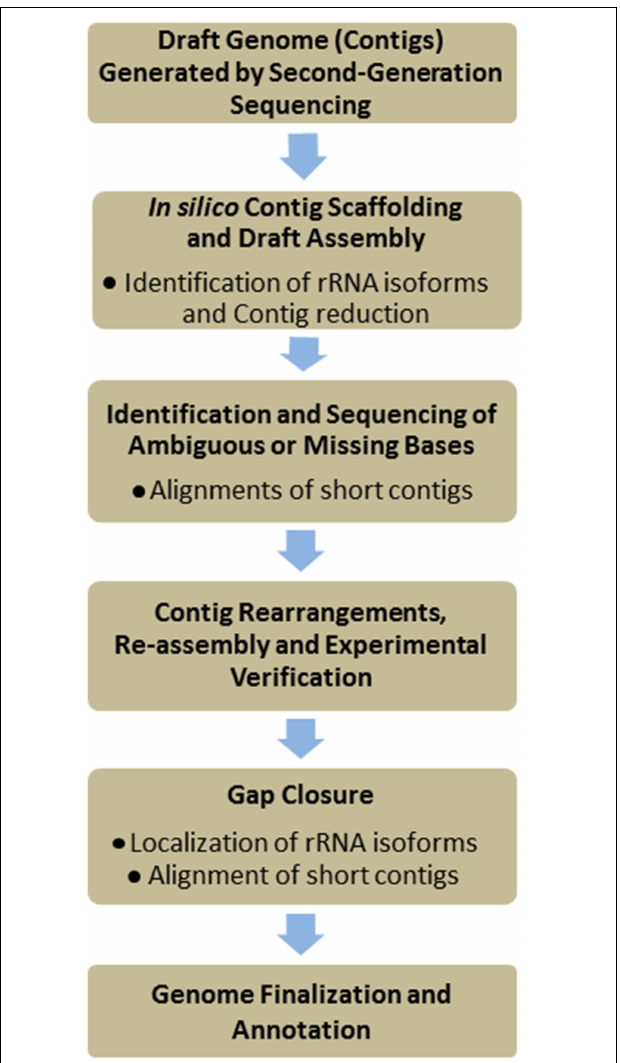
FIGURE 2 | Flow chart for de novo bacterial genome finishing. The assembly process is initially simplified by removal of contigs comprised entirely of rRNA genes. The draft genome is then scaffolded against other closely related strains and species to identify potential gaps, rearrangements, and missing sequences. Ambiguities in structure and nucleotide identity are targeted for Sanger re-sequencing. Furthermore, large scale rearrangements are carefully investigated through a combination of PCR and sequencing to ensure mistakes are not incorporated during draft genome assembly. Finally gaps between contigs are sequenced and the genome is assembled and